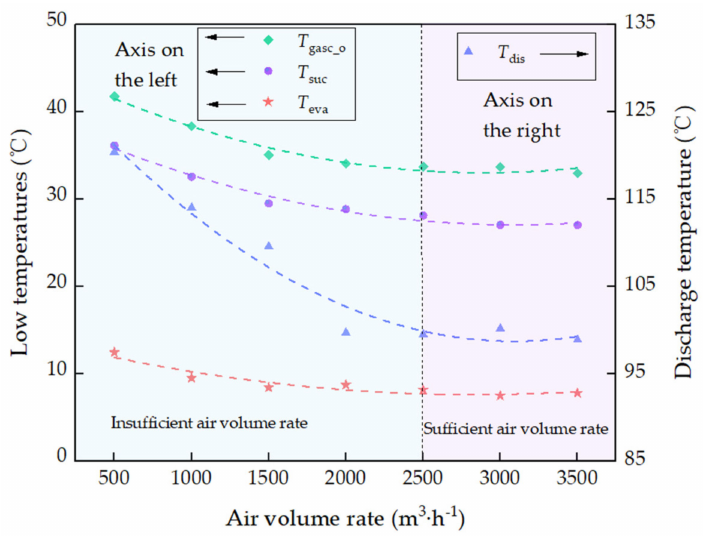
Figure 2. Effect of the air volume flow rate in the gas cooler on the key temperatures of the investi- gated